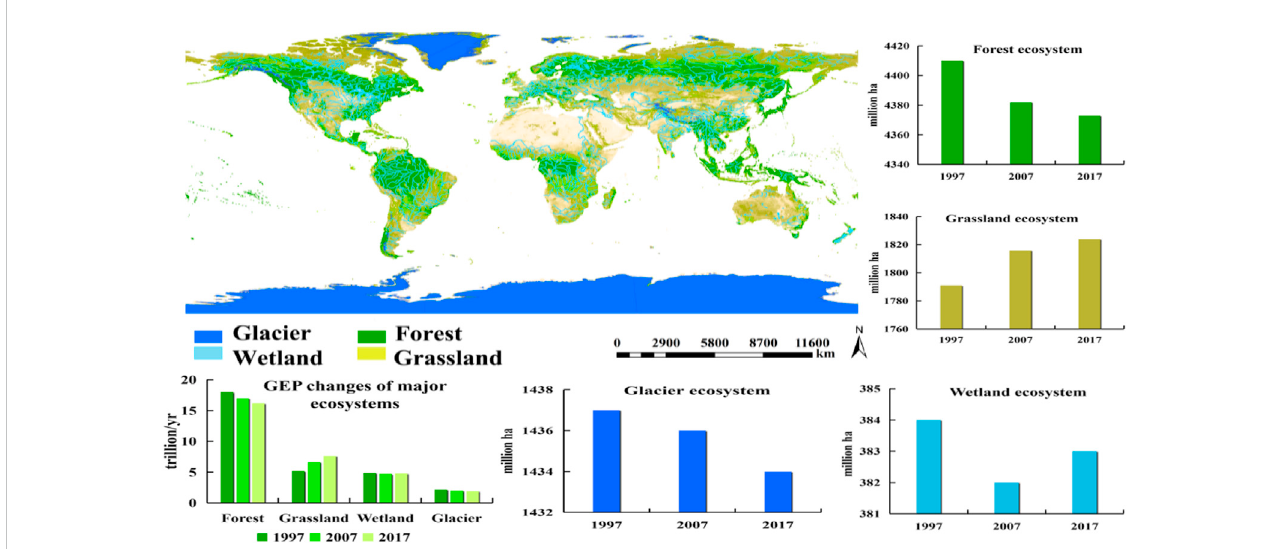
FIGURE 5 Main global ecosystem types and changes. Note: the main ecosystem change data sourced from the World Bank (WB) (https://data.worldbank.org/ accessed 1 October 2021) and the Food and Agriculture Organization of the United Nations (FAO) (https://www.fao. org/accessed 10 October